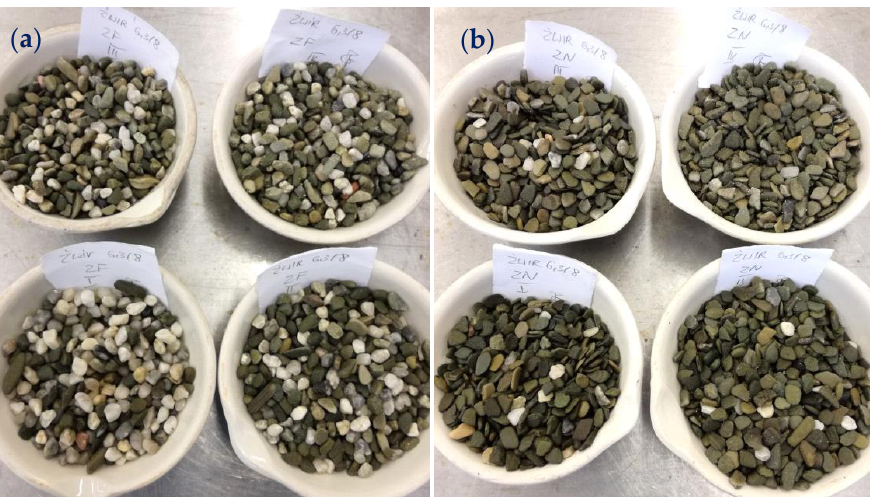
Figure 4. Separation products: regular particles ( a ) (Test VI), irregular particles ( b ) (Test V). Calculated averaged values of absorbability and density are presented in Table 6.